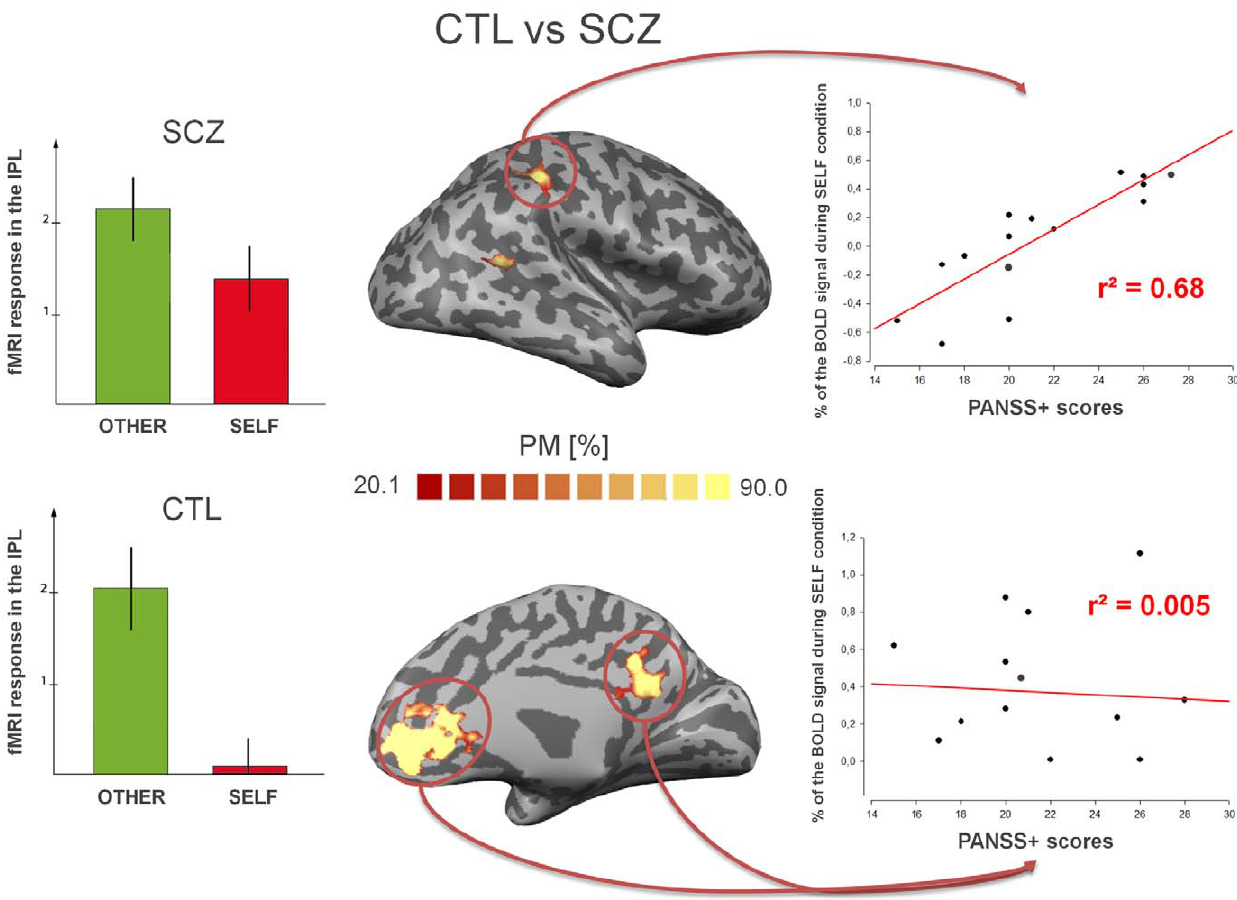
Figure 2. The self-other distinction network in patients with schizophrenia, compared with healthy controls. In the middle column, the red-to-yellow colour-code represents the relative percentage of subjects with greater activity in the [EGV – SGV] contrast, after we performed cortex- based normalization between the healthy matched controls (CTL) and the patients suffering from schizophrenia (SCZ). %PM: percentage of activity in the subjects included at a specific spatial location, in a range from 20 to 90 (spatial consistency). In the patients, the difference in the [EGV – SGV] contrast was significantly less marked than for the controls, which was also confirmed by the mean haemodynamic response of the fMRI signal in the right inferior parietal lobule (IPL). This is shown for each group in the left panel. The green bars represent the EGV condition, and the red bars show the SGV condition. In the right column, correlation analysis (adjusted for the dosage of the antipsychotic drugs) between the intensity of the fMRI signal in the self-other distinction network and the severity of the positive symptoms in schizophrenia (PANSS positive subscale) is shown.